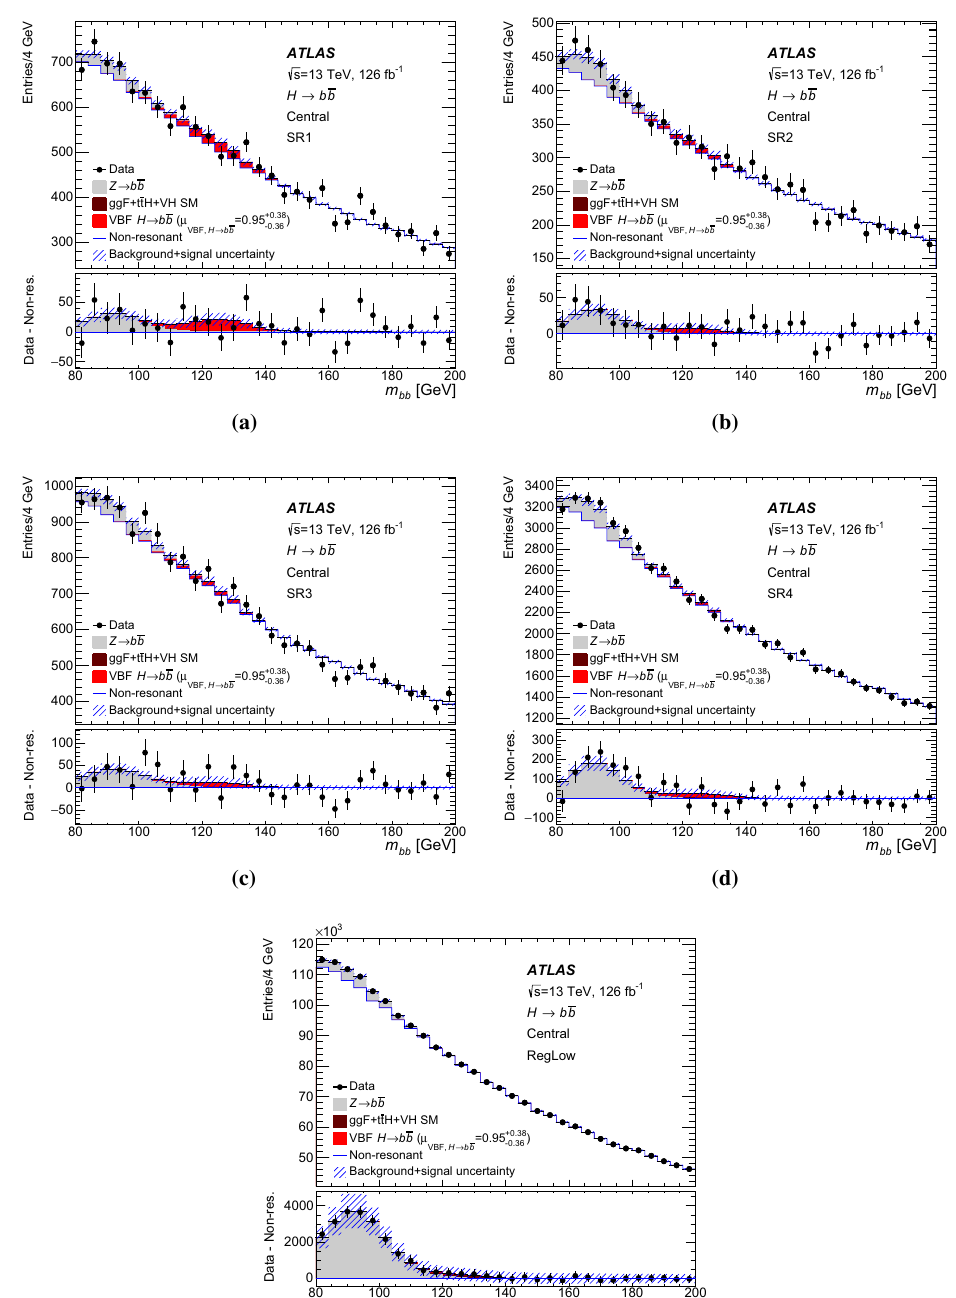
Fig. 5 Fit results for the Central channel. Top left is SR1, top right is SR2, middle left is SR3, middle right is SR4, bottom is RegLow. The data are the black points, the blue line is the non-resonant background shape (continuum), grey is the resonant background ( Z → b ¯ b ), red is the fitted VBF Higgs boson signal (VBF H → b ¯ b ), and maroon are events attributed to the other Higgs boson production mechanisms (ggF + t ¯ tH + V H ). The bottom panel of each plot shows the difference